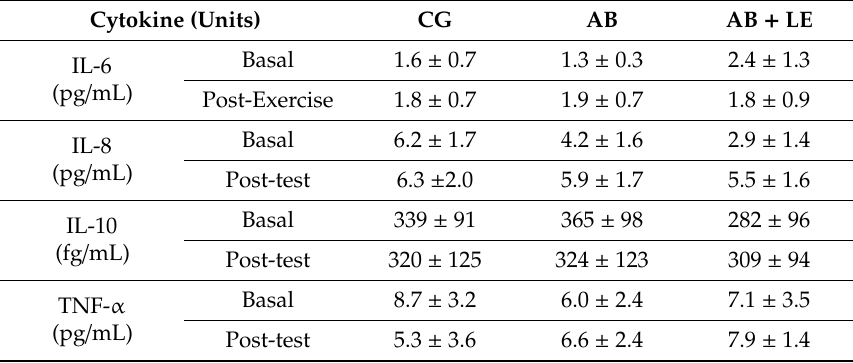
Table 6. Plasma cytokine levels determined in basal conditions and immediately after the 2000-m test in control (CG), almond beverage (AB) and almond beverage + Lippia extract (AB + LE) groups.